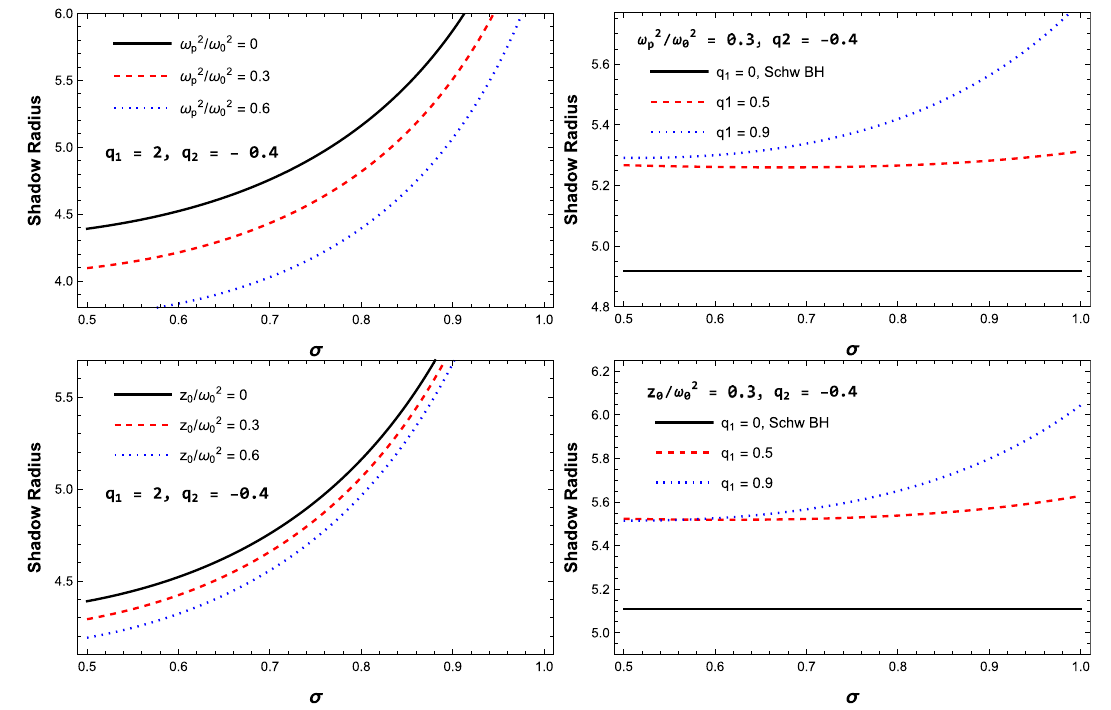
Fig. 11 The dependence of shadow radius on σ for selected values of q 1 and q 2 in uniform (upper panels) and non-uniform (lower panels) plasma. In the left panels q 1 and q 2 are fixed while plasma frequency